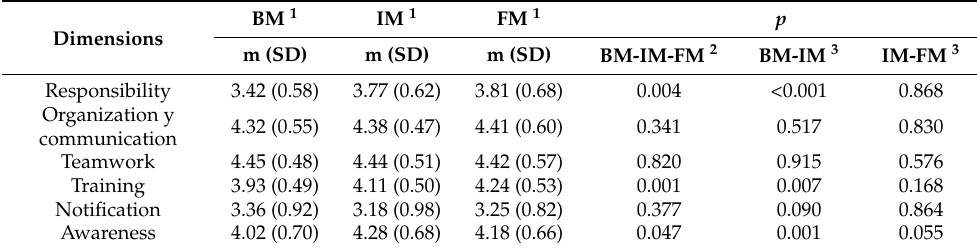
Table 2. Analysis of the dimensions of the questionnaire ( N =